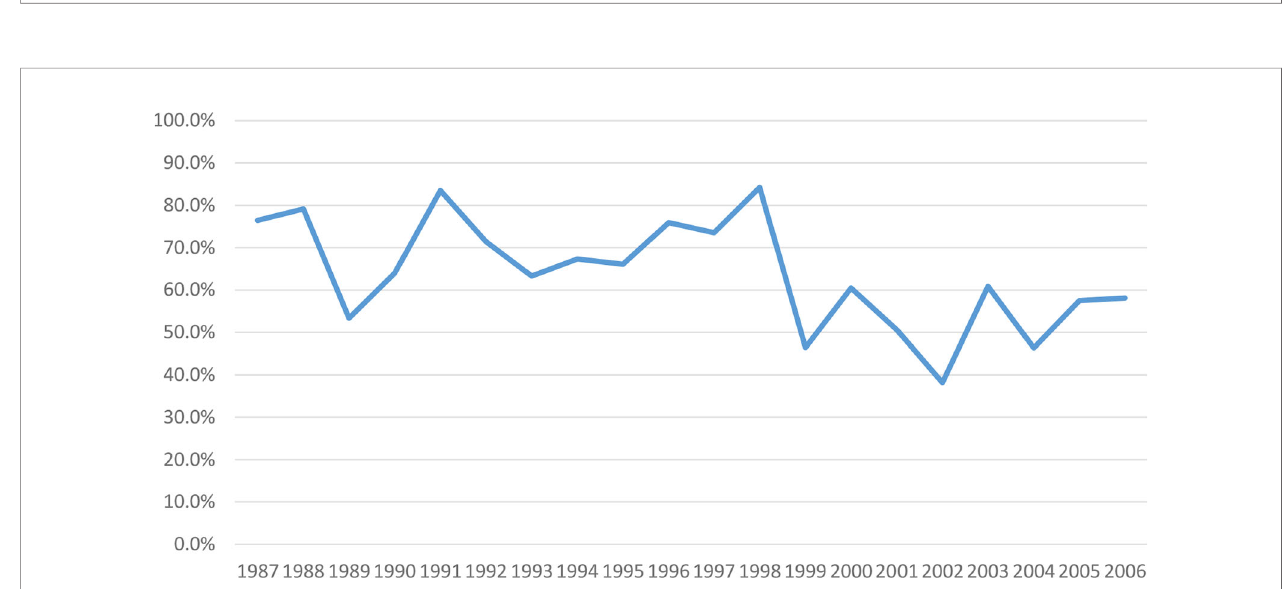
FIGURE 3 | Post-Primary series PRNT 80 immune response to WEE vaccine by year within FY87-8 and FY99-12 (1987 – 2005). The immunogenicity of WEE TSI-GSD 210 appeared to decline from 53 to 23%.